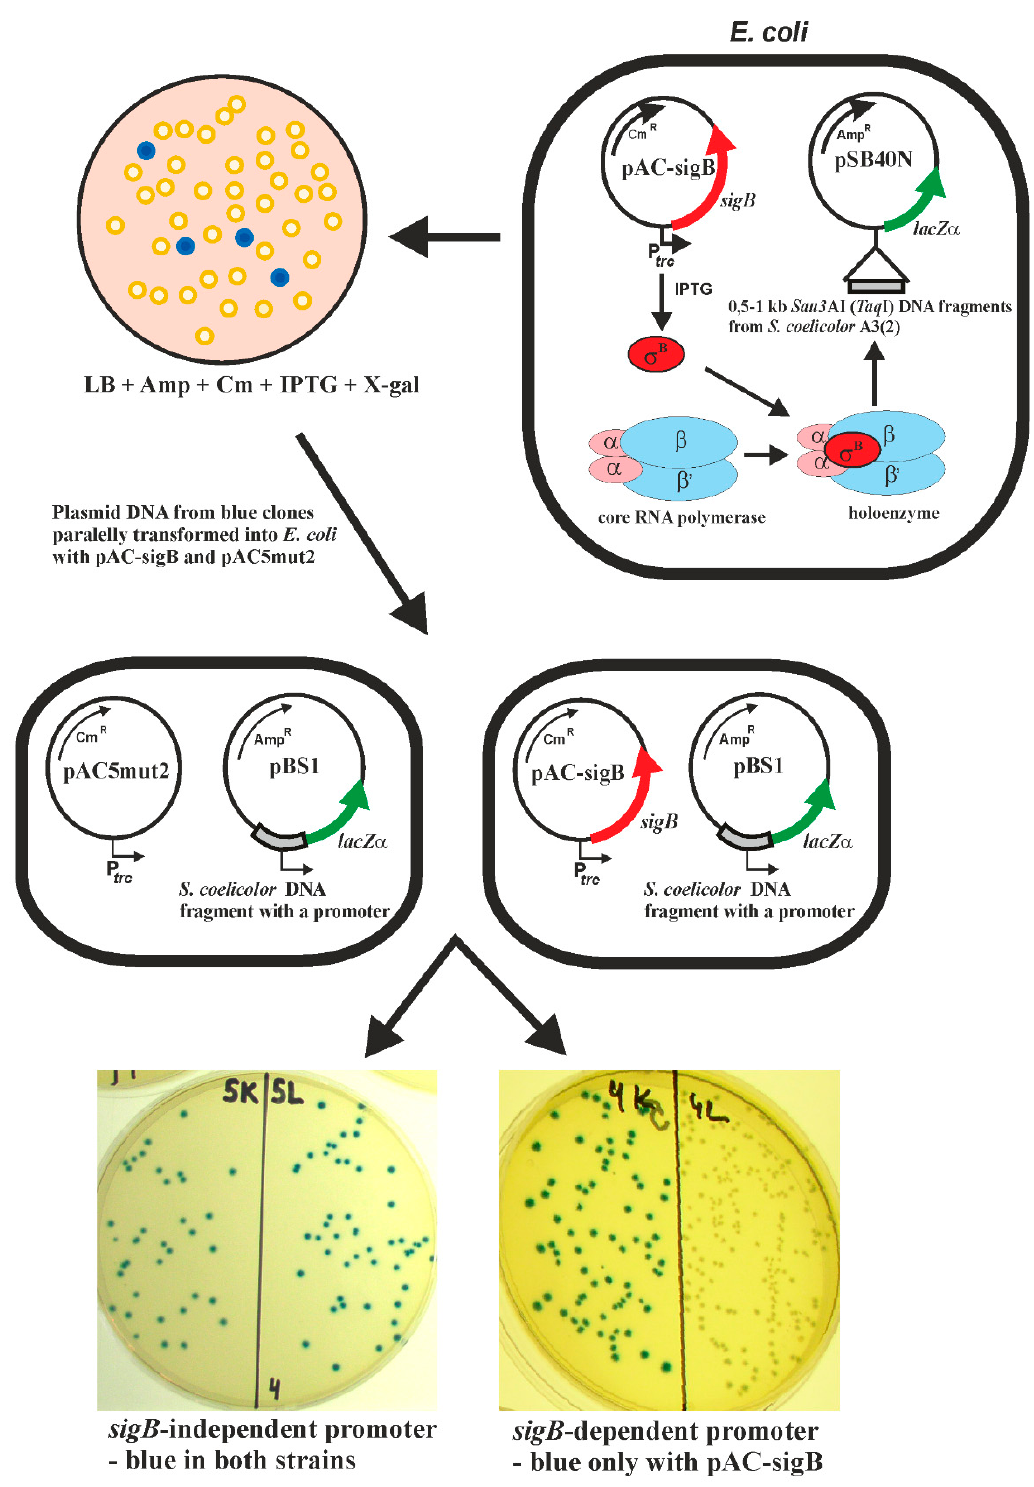
Figure 2. Scheme illustrating the E. coli two-plasmid system for identifying sigma factor-dependent promoters (in this case SigB). A library of Sau3 AI or Taq I DNA fragments from S. coelicolor A3(2) in pSB40N [36] was transformed into E. coli with the expression plasmid pAC-sigB containing the sigB gene under the control of the inducible trc promoter and screened on X-gal selective plates. Plasmid DNA from the blue colonies was subsequently transformed into two E. coli strains; one strain with the expression plasmid alone (pAC5mut2), and the other with pAC-sigB. The SigB-independent promoter is active in both strains, and SigB-dependent only in E. coli with pAC-sigB. The final plates with E. coli containing a sigB -independent or sigB -dependent promoter are shown.